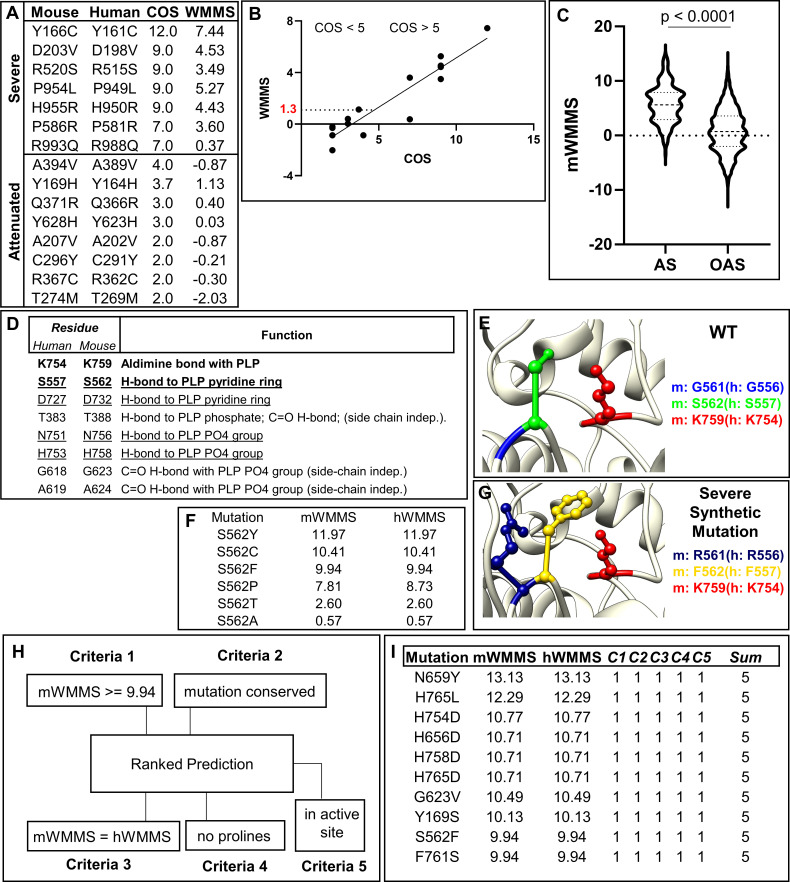
Prediction and selection of a pathogenic mutation to induce a mouse model of severe disease.[A] Fifteen homozygous human mutations where hWMMS is the same as mWMMS and their assigned human clinical outcome scores (COS) from Farris et al. 2020[16] are presented. [B] Distribution of WMMS for mutations (from panel A) predicted to be attenuated (COS ≤ 5) and severe (COS > 5). The distribution follows the trend y = 0.76*x—2.5; r2 0.9. The WMMS transition from severe to attenuated state is predicted to be linear and projected to occur at a score of 1.3. [C] Distribution of mWMMS values for theoretical mouse mutations inside (N = 204) and outside (N = 5,243) the GLDC the active site. Active site mutations have a mean mWMMS of 5.8, while mutations outside the active site have a mean mWMMS of 0.6. The two distributions are significantly different (P < 0.0001) by unpaired student’s t-test. [D] Active site residues that form hydrogen-bonds relevant for catalysis. Active site lysine and lead severe mutation candidate, S562F, are shown in bold. Side-chain dependent hydrogen-bonds are underlined. [E] The position of G561 (blue) and S562 (green) relative to active site K759 (red) [F] Possible S562 substitutions, mWMMS and corresponding hWMMS’s are shown for each substitution. [G] Representation of the double synthetic mutations G561R (dark blue), S562F (yellow) in GLDC. Active site lysine (K759) is shown in red. [H] WMMS (mouse and human) and other molecular ranking criteria for inclusion in severe mutation selection model. [I] The 10 theoretical mutations that scored in all five criteria laid out in 6F. Note, S562C and S562Y shown in panel D are excluded because they were previously not predicted to disrupt the hydrogen bond of S562.